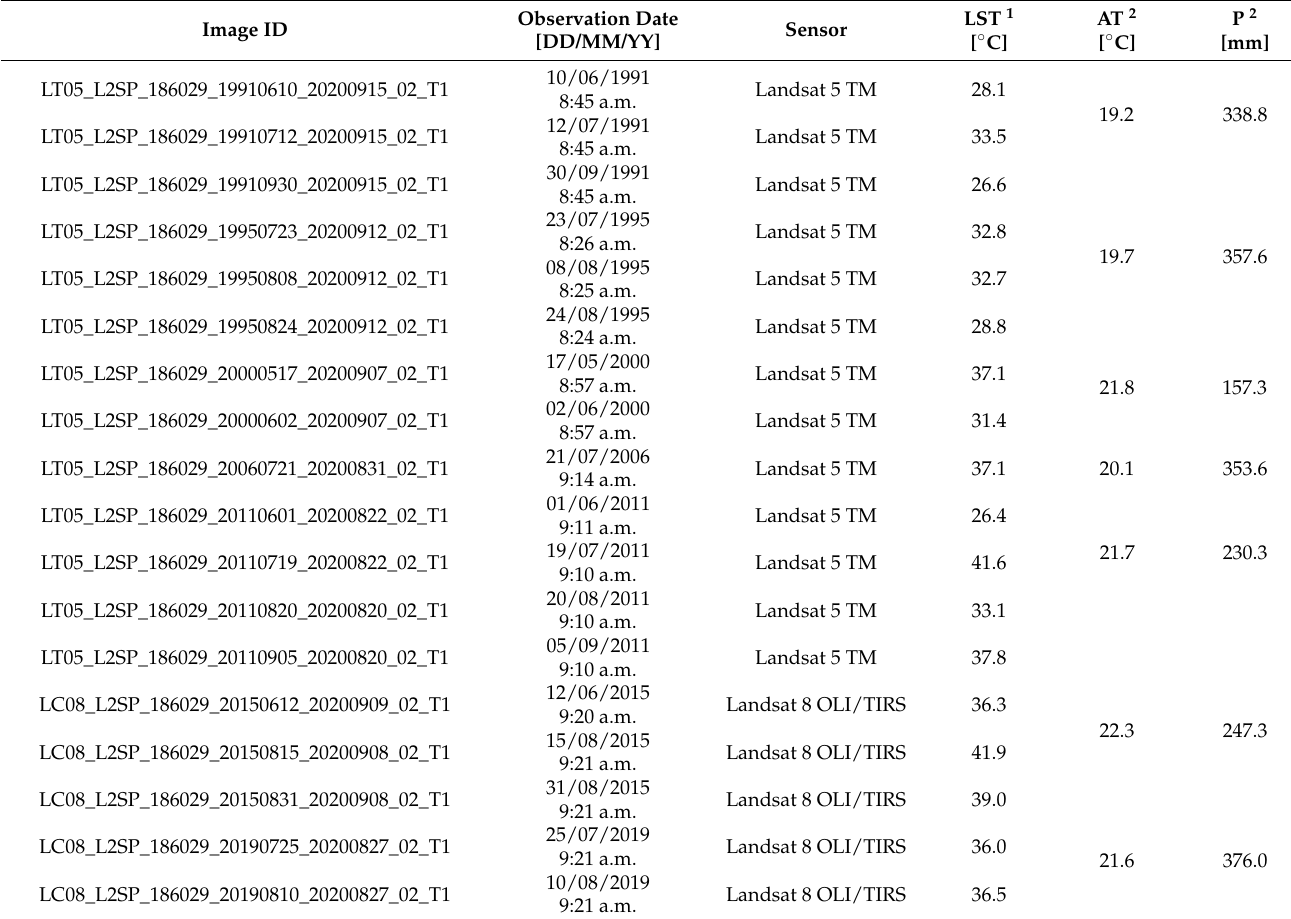
Table 1. Remote sensing and climate data used in the